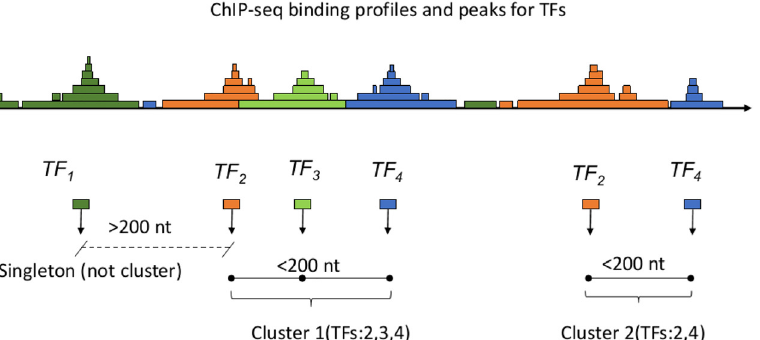
Figure 3: The example of